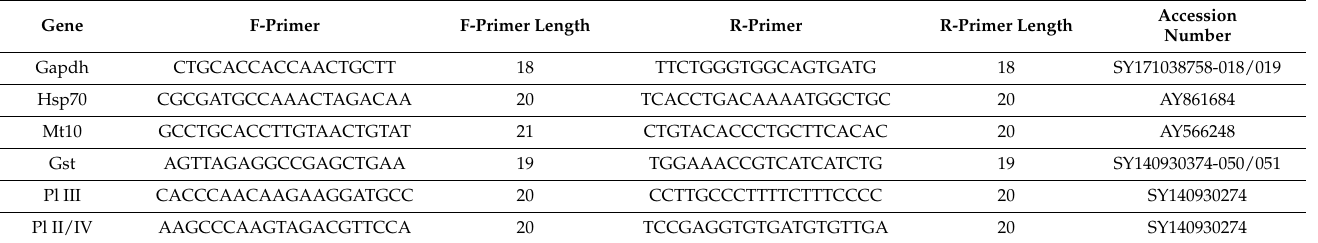
Table 1. List of forward and reverse primers used for amplification of each gene analysed and for the reference housekeeping GAPDH